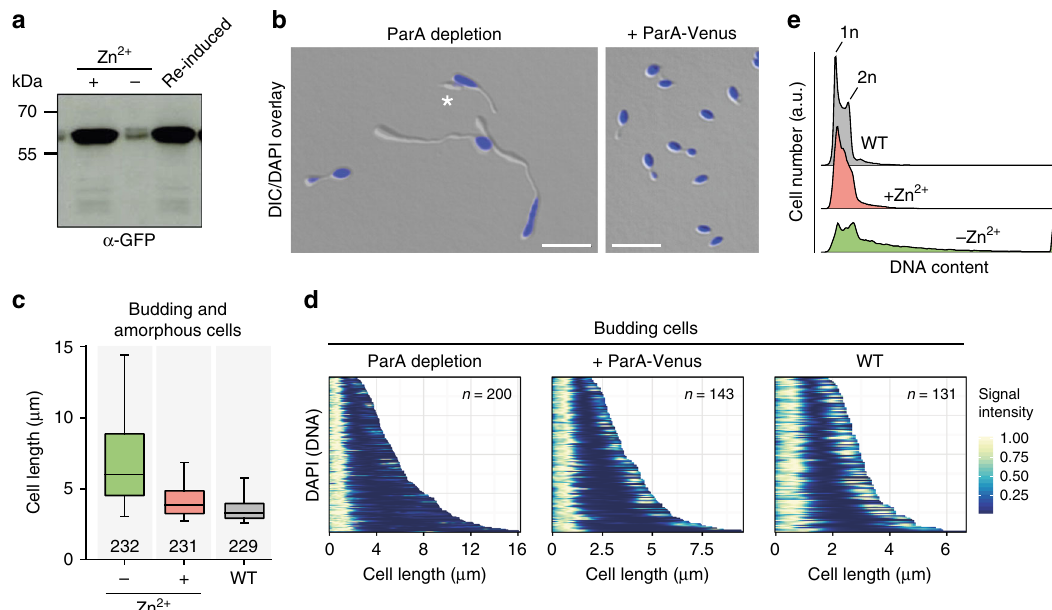
Fig. 4 Effect of ParA depletion on chromosome partitioning. a Immunoblot showing the levels of ParA-Venus in strain AJ46 ( Δ parA P Zn ::P Zn - parA-venus ) under inducing and non-inducing conditions. Cells were grown in MB medium containing inducer (0.3 mM ZnSO 4 ), washed, shifted to ZnSO 4 -free medium, and cultivated for another 45 h to deplete ParA-Venus. Subsequently, cells were transferred to MB medium containing 0.5 mM ZnSO 4 and cultivated for 24 h to re-induce the synthesis of the fusion protein. Samples were subjected to immunoblot analysis with anti-GFP antibodies. A full scan of the immunoblot is shown in Supplementary Fig. 9A. b Microscopic analysis of cells depleted of ParA. Cells of strain AJ46 ( Δ parA P Zn ::P Zn - parA-venus ) were grown in MB medium with or without 0.3 mM ZnSO 4 and incubated for 20 min with DAPI to stain the chromosomal DNA prior to imaging. Shown are overlays of DIC and fl uorescence micrographs. The asterisk denotes an anucleate cell. Bars: 5 µ m. c Box plots showing the length distributions of budding and amorphous cells from the cultures described in ( b ). The horizontal line indicates the median, the box the interquartile range, and the whiskers the 5th and 95th percentiles. The number of cells analyzed is given underneath the boxes. Wild-type cells grown in MB medium were analyzed as a control. Source data are provided as a Source Data fi le. d Demographic analysis of the distribution of chromosomal DNA in budding cells from the cultures described in ( b ). The fl uorescence intensity pro fi les of random subpopulations of cells were stacked on top of each other according to cell length, with the mother cell body positioned to the left and the bud positioned to the right. e Flow cytometric analysis of the chromosome content of ParA-depleted cells. Strain AJ46 ( Δ parA P Zn ::P Zn - parA-venus ) was grown in MB medium without or with 0.3 mM ZnSO 4 . After staining of the chromosomal DNA with Vybrant DyeCycle Orange